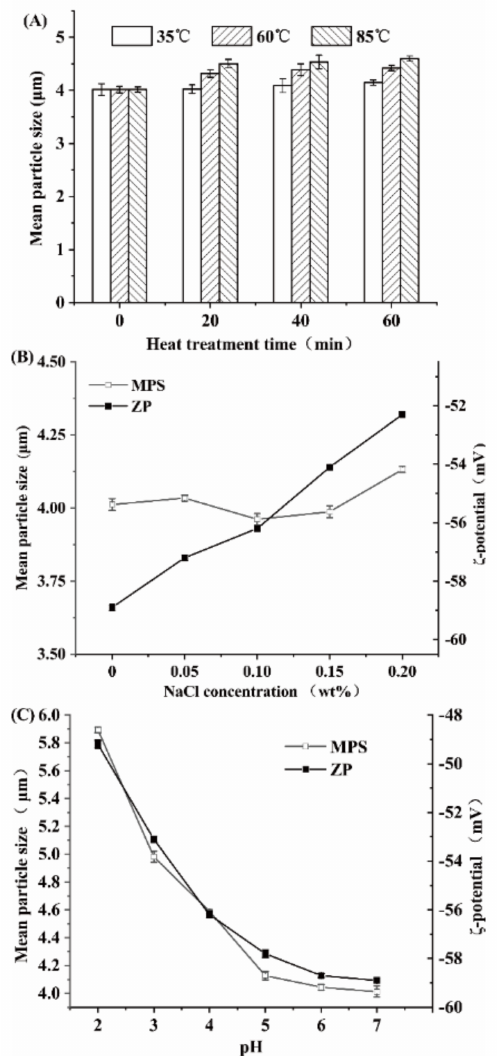
Figure 4. Effect of temperature ( A ), NaCl salt ( B ), and pH ( C ) on the stability of HA-stabilized β -carotene